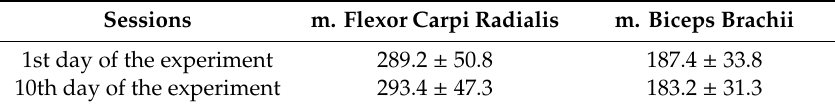
Table 2. Mean ± SD muscle sti ff ness (N / m) on the first and 10th days of the experiment.